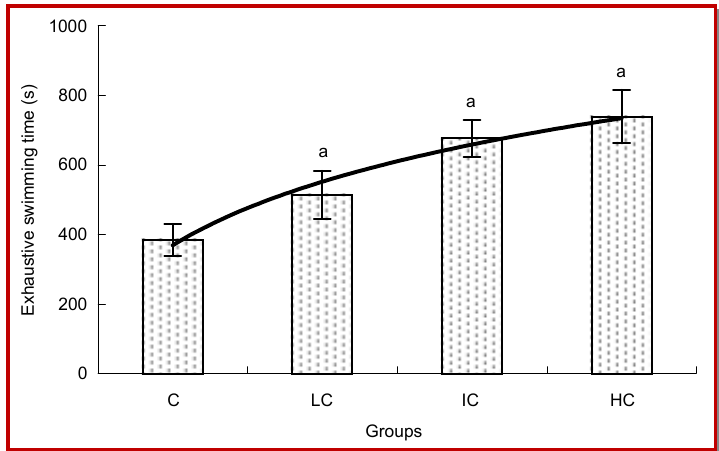
Figure 1: The effect of CSP on the exhaustive swimming time of mice. Data are expressed as mean ± S.D. a p<0.05 compared with control group